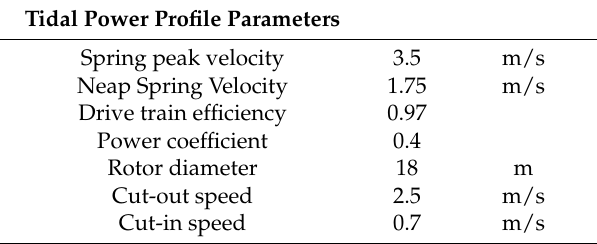
Table 1. Parameters used for obtaining simplified tidal power